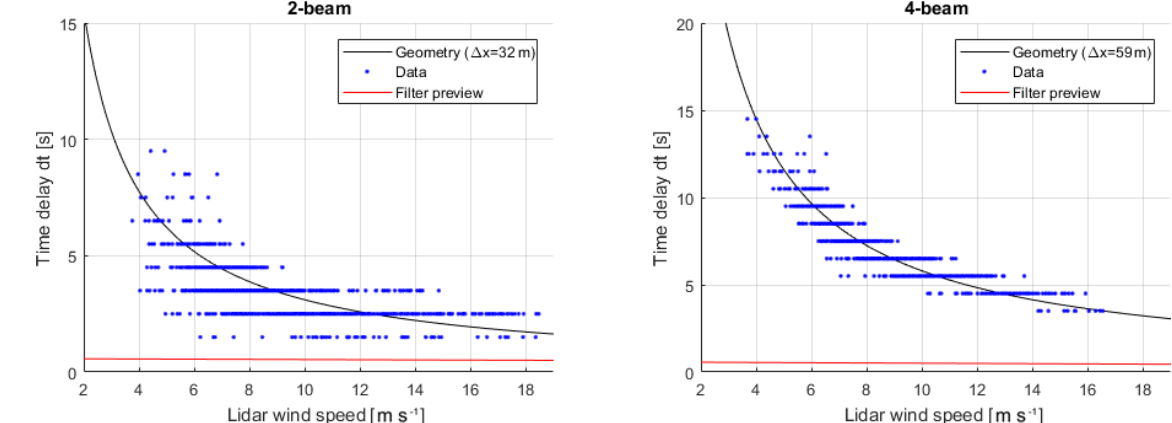
Figure 12. Delay time analysis results for the two-beam and four-beam lidars. Delays and advection speeds are calculated based on 10min averages. The required filter time of a first-order Butterworth filter is also